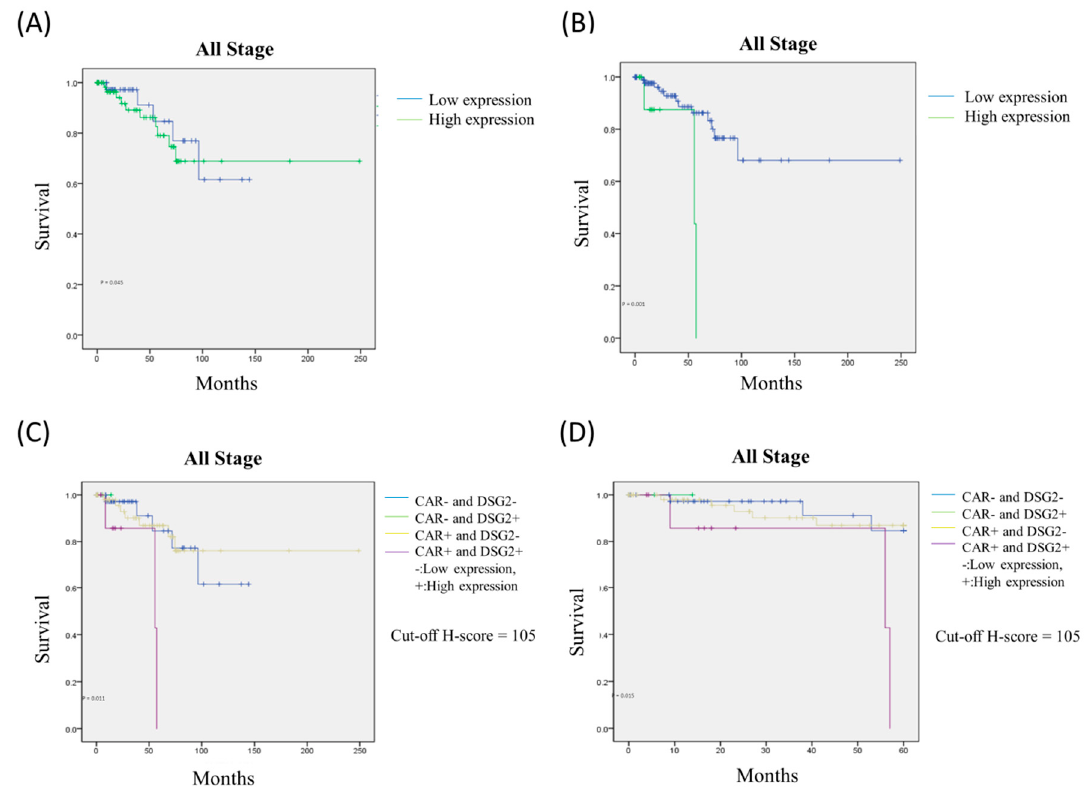
Figure 7. The Kaplan–Meier survival analysis for ( A ) CAR, ( B ) DSG2, and high CAR/DSG2 expression in ( C ) 250 months and ( D ) 60 months. Table 3. Cox regression analysis of CAR vs.